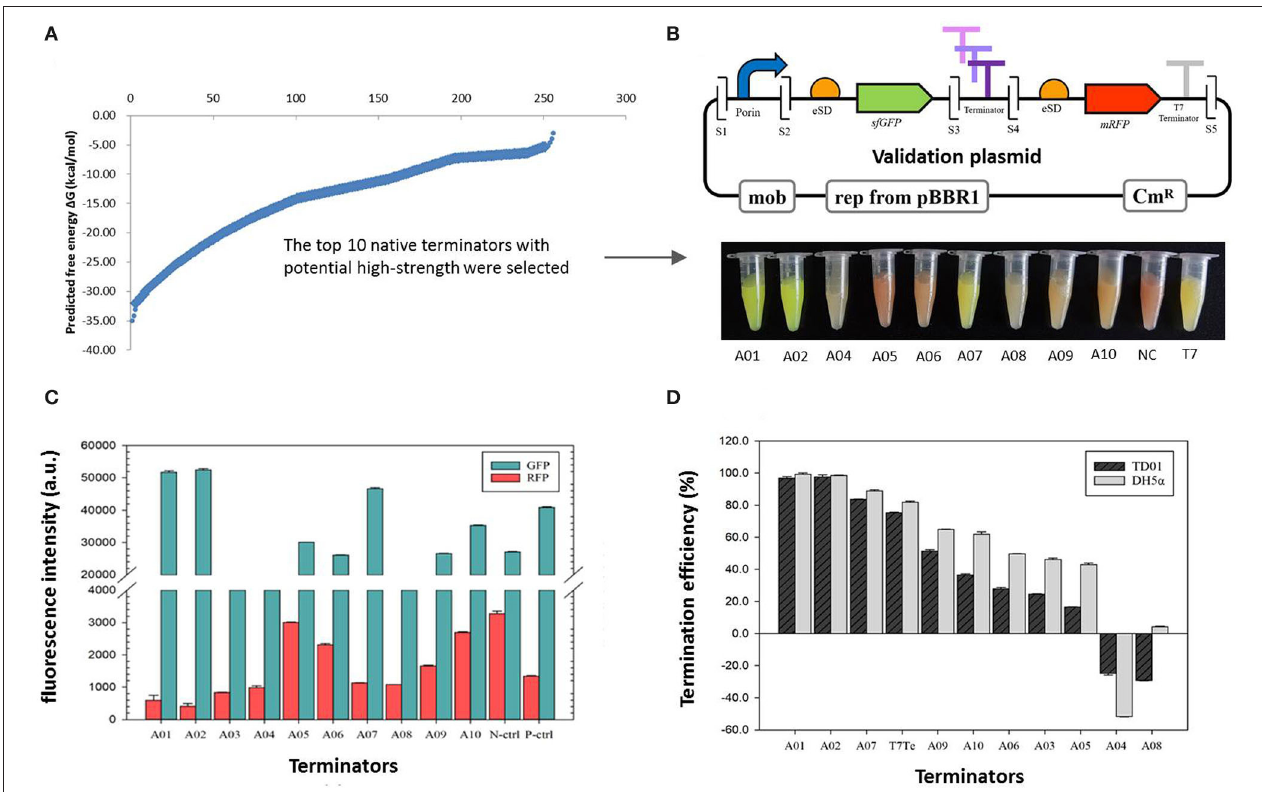
FIGURE 2 | The validation of termination efficiencies of 10 native intrinsic terminators in H. bluephagenesis TD01. (A) The distribution of the free energies 1 G W of the 256 native intrinsic terminators mined by RNA-seq data in H. bluephagenesis TD01. The top 10 with potential high efficiencies were selected via a reported primary rating system. (B) The validation plasmids constructed by Golden Gate assembly (up) and the recombinant H. bluephagenesis TD strains harboring different terminators showed a variety of colors reflecting different termination efficiencies (down). S1-S5 indicates five Bsa I sites. (C) The normalized fluorescence intensity of the GFP and RFP in the recombinant H. bluephagenesis TD strains harboring the 10 terminators. (D) The termination efficiencies of the 10 terminators in both H. bluephagenesis TD01 and E. coli DH5 α . Errors were calculated from three parallel